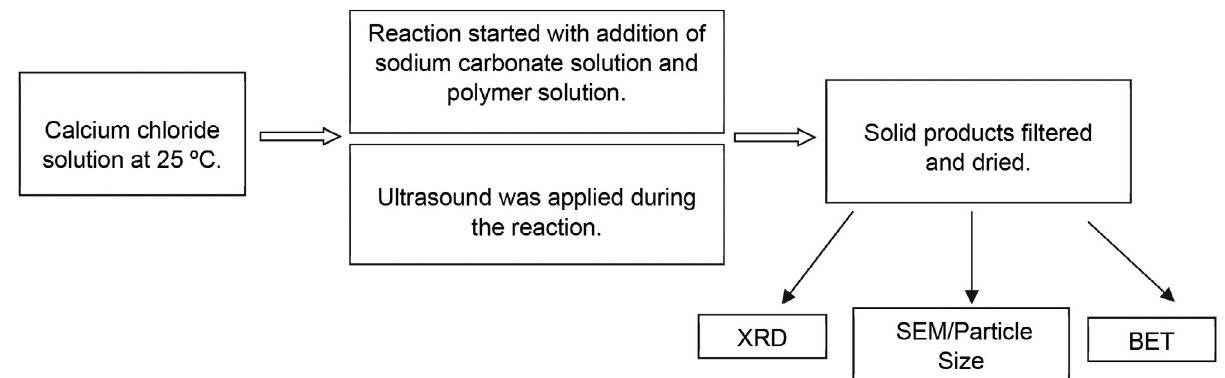
Figure 1. Schematic representation of the synthesis of calcium